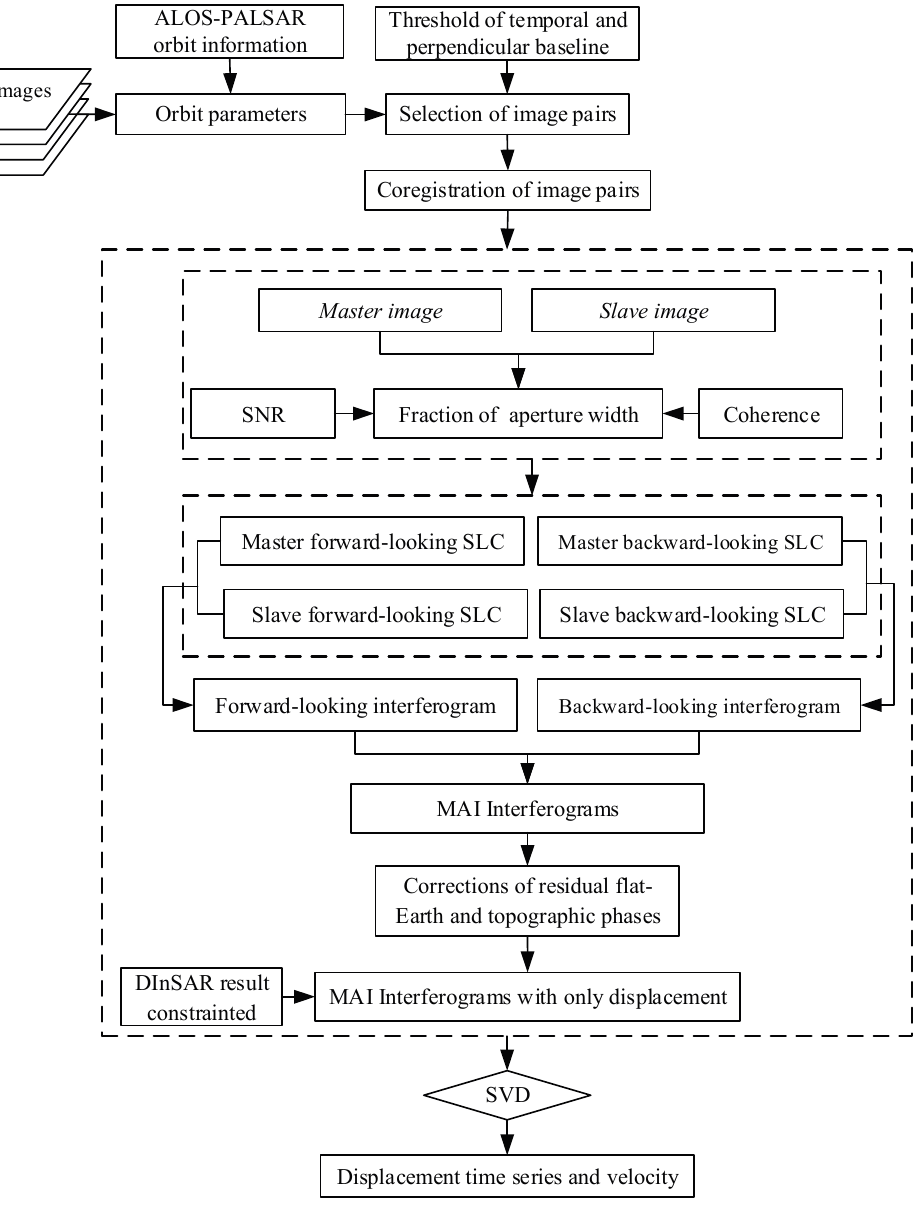
Figure 4. Flowchart of the multiple-aperture synthetic aperture radar interferometry based small baseline subset (MAI-SBAS)